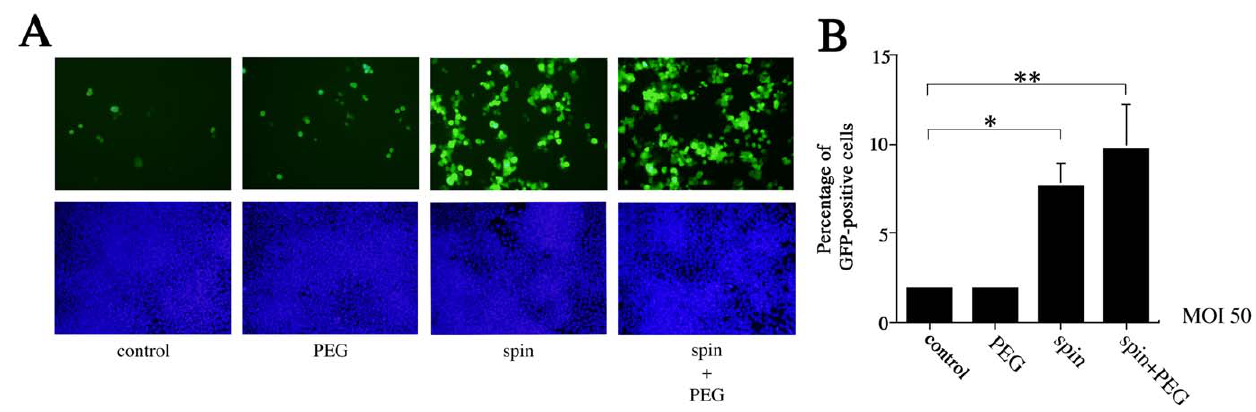
Figure 6. Effects of polyethylene glycol and centrifugation on EF-1 a -promoter recombinant MCMV infection in ES cells. (A) GFP- positive cells in ES cultures treated with 44% PEG, centrifugation + PBS, or centrifugation + 44% PEG after infection with EF-1 a recombinant MCMV at an MOI of 50. (B) Flow cytometry was used to verify the proportion of GFP-positive cells in each of the infection treatments. All presented experiments were performed at least 3 times, and data are given as the mean 6 SD. * P , 0.05, ** P , 0.01, t- test.